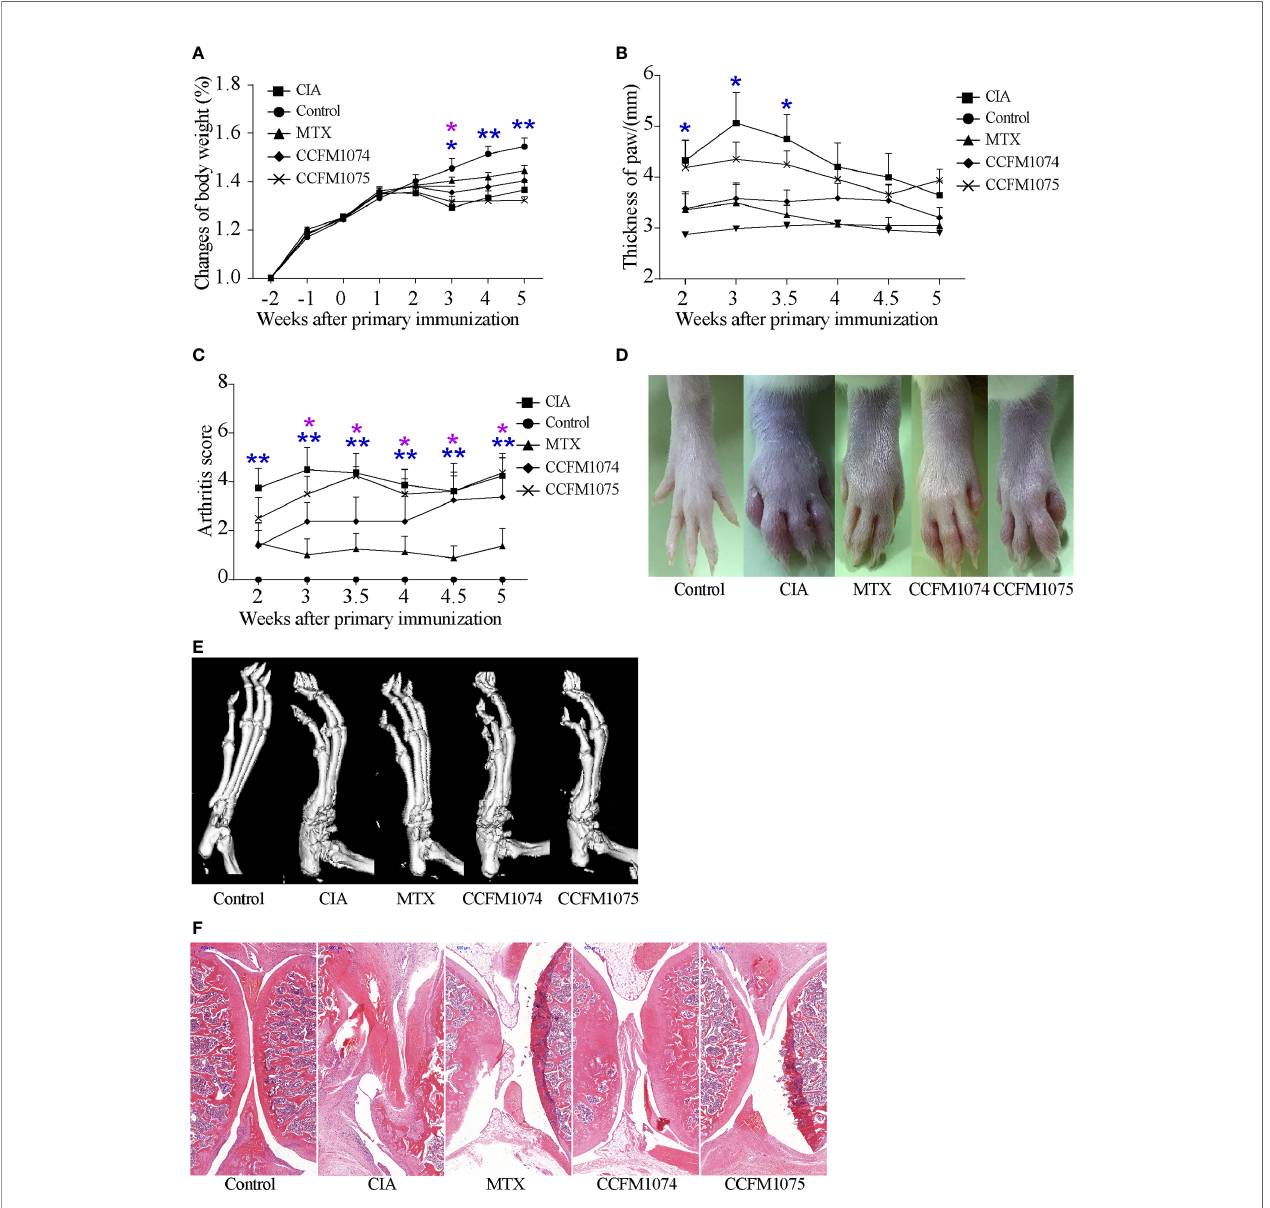
FIGURE 1 | Effects of L. casei on CIA in rats. (A) Change of body weight, (B) Thickness of the paws, (C) arthritis score. Representative photographs of paw (D) and representative microCT images of paw (E) . control (vehicle-treated with saline 1.5 mL/day) group, CIA (vehicle-treated with saline 1.5 mL/day) group, methotrexate (MTX)-treated (6 mg/kg/week) group, CCFM1074 (treated with CCFM1074, 8.5 × 10 9 CFU/day) group and CCFM1075 (treated with CCFM1075, 8.5 × 10 9 CFU/ day) group, eight rats per group. The representative histopathological sections of knee were determined by H&E staining (scale bar 500 m m) (F) . * p <0.05, ** p <0.01 (two-way ANOVA with Dunnett ’ s multiple comparisons test). Blue *, CIA vs . Control; purple *, CIA vs .